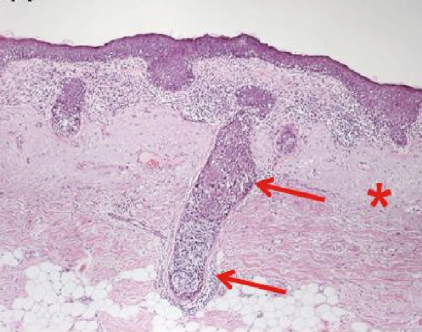
Figure 2: Skin target of lentigo maligna. The radiotherapy dose needs to treat 5 mm depth as lentigo maligna can invade down adnexal structures causing in-field